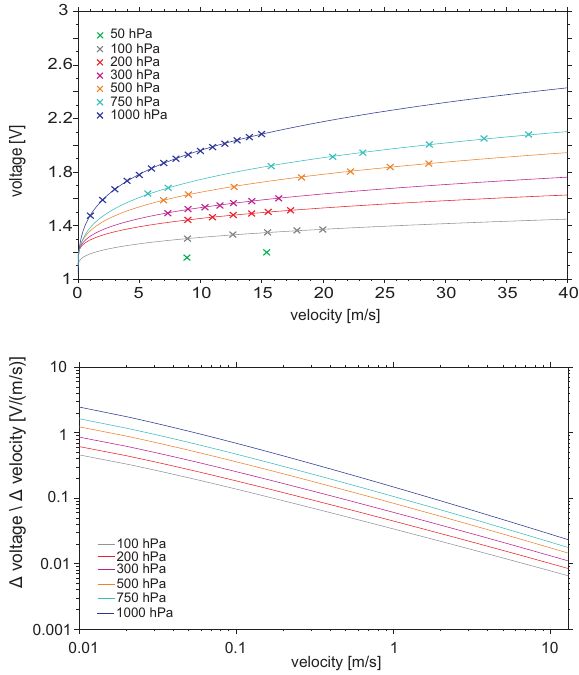
Fig. 4. Results of the vacuum chamber tests. The King’s law (thin line) was fitted to the CTA voltage signals (data points) as a func- tion of velocity for different pressure levels (top). At 50hPa, only two points are obtained. Thus the King’s law fit is omitted due to remaining ambiguities. The sensitivity of the CTA signal as a func- tion of velocity at different pressure levels is shown in the bottom